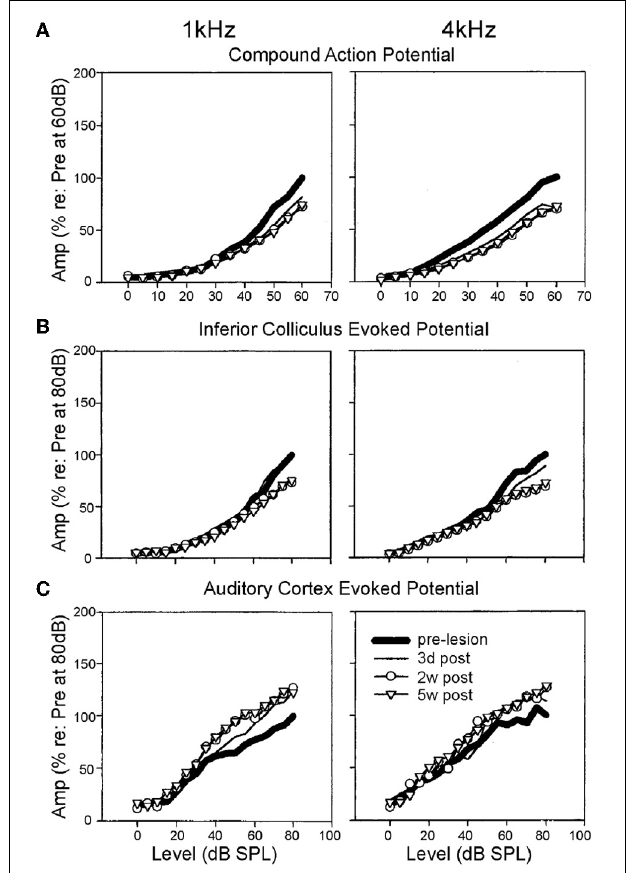
FIGURE 3 | Specific elevation of auditory evoked rate level functions after selective inner hair cell ablation. Following systemic injection of carboplatin (various doses) into chinchillas, the selective IHC lesion that develops was evaluated by chronic electrode implantation with measurement of evoked field response functions from the cochlear compound action potential (A) , the inferior colliculus (B) and the auditory cortex (C) in the awake animal in response to 1kHz (left column) and 4kHz (right column) tonal acoustic stimulation. By recording prior to lesion induction (thick lines), 3 days (thin lines), 2 weeks (circles) and 5 weeks (triangles) after lesioning, there was found to be a maintained suppression of evoked response amplitudes in both the cochlea and the inferior colliculus; paradoxically, IHC ablation yielded a marked enhancement of evoked response functions recorded from the auditory cortex. Modified with permission from Qiu et al.